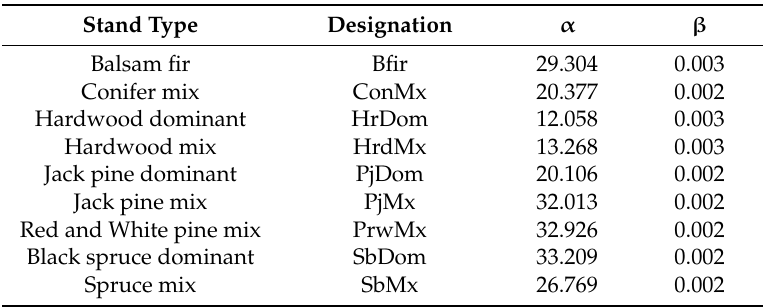
Table 4. Smoothed windthrow vs. windspeed model parameter